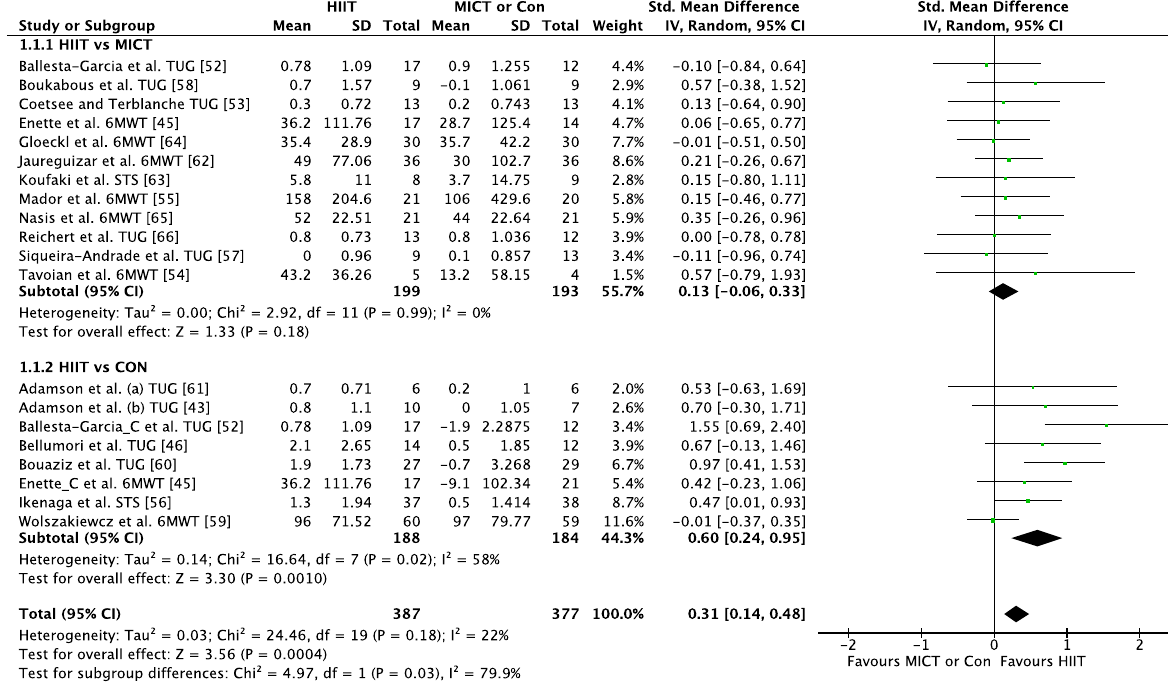
Fig. 2 Meta-analysis subgroups HIIT versus MICT, HIIT versus Control with single outcome for each